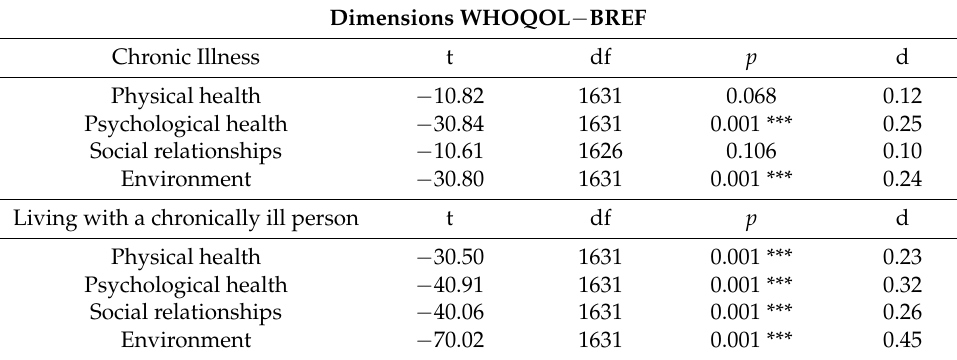
Table 4. Student’s t test results according to whether participants have a chronic illness or are living with a chronically ill